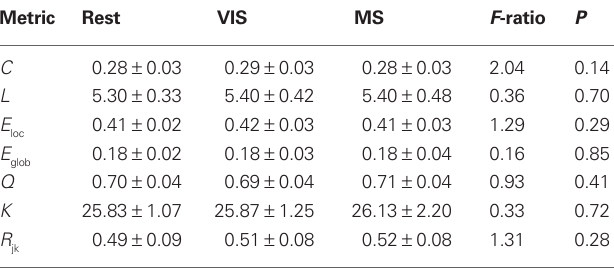
Table 1 | Mean whole-brain network metrics for S = 3.0.